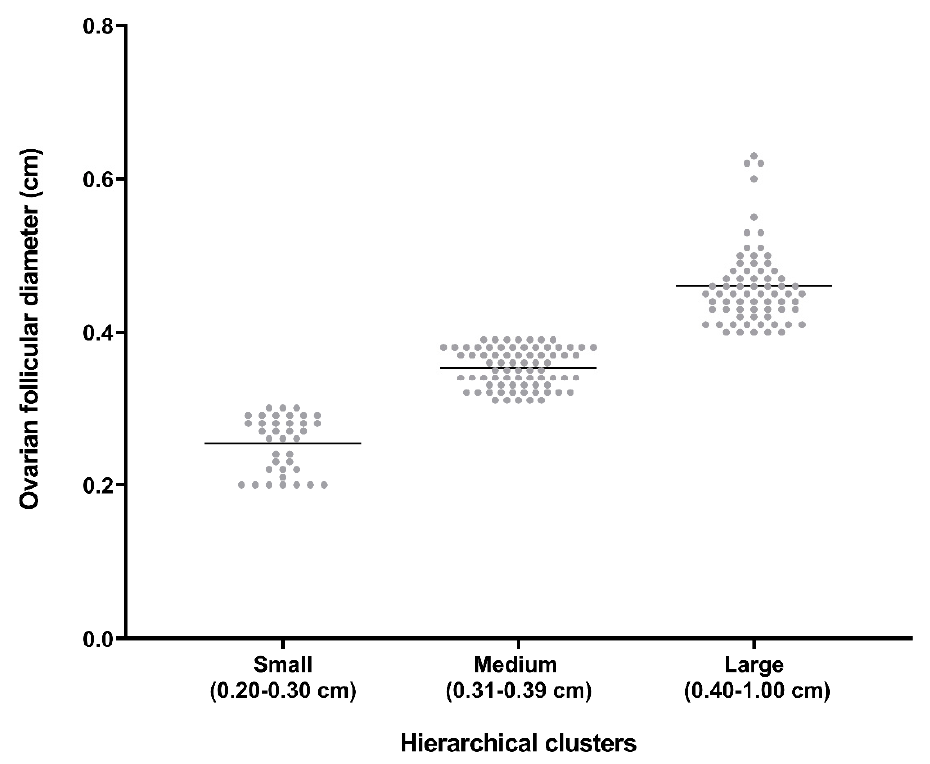
Figure 1. Distribution of the sows in three clusters, defined objectively by hierarchical cluster analysis ( p < 0.001), according to average ovarian follicular diameter at weaning.